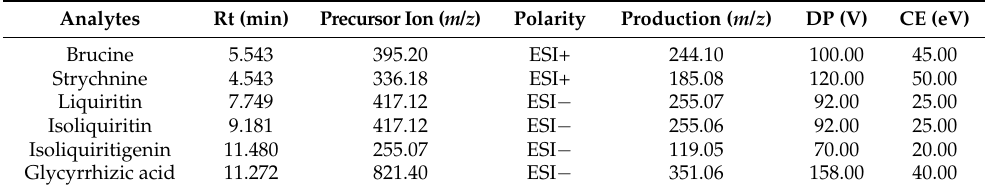
Table 10. Chromatographic and mass spectrometric parameters of MRM mode. Analytes Rt (min) Precursor Ion ( m / z ) Polarity Production ( m / z